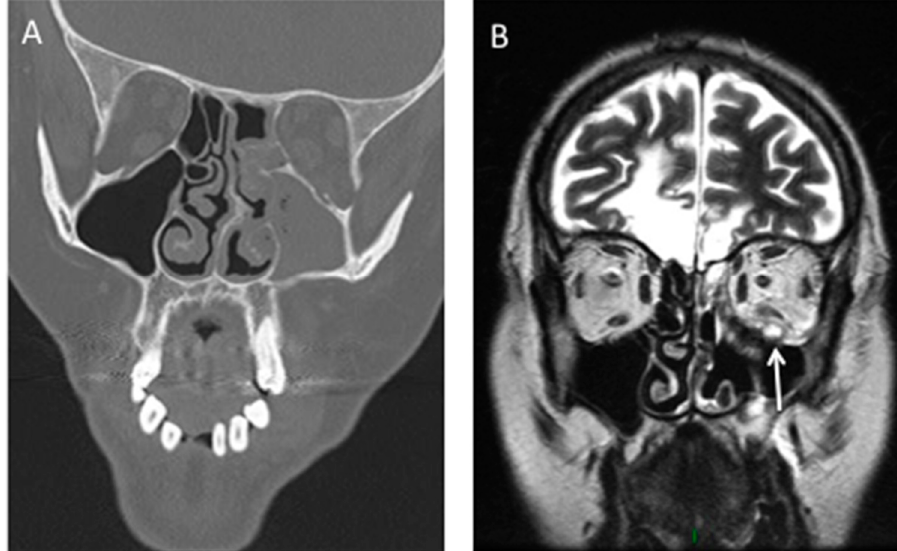
Figure 2. Rhino-Orbito-Cerebral mucormycosis in a diabetic patient. ( A ): CT scan shows left maxillary, ethmoidal and sphenoidal sinusitis complicated by osteolysis of the maxillary sinus. ( B ): Coronal T2-weighted MR image shows intra-orbital mass (arrow) compatible with fungal extension.